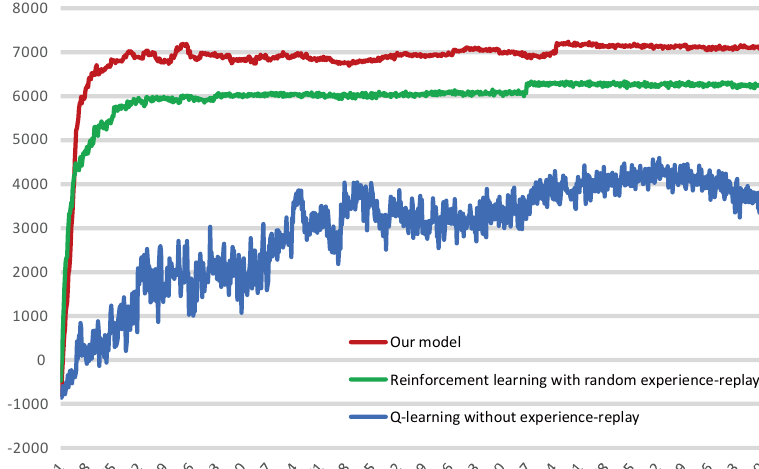
Figure 16. Average reward obtained by the agent per navigation. The red curve represents our model, the green curve represents reinforcement learning with random experience replay and the blue represents Q-learning without experience-replay. Table 2. Partial data intercepted within the stabilization interval and their averages.